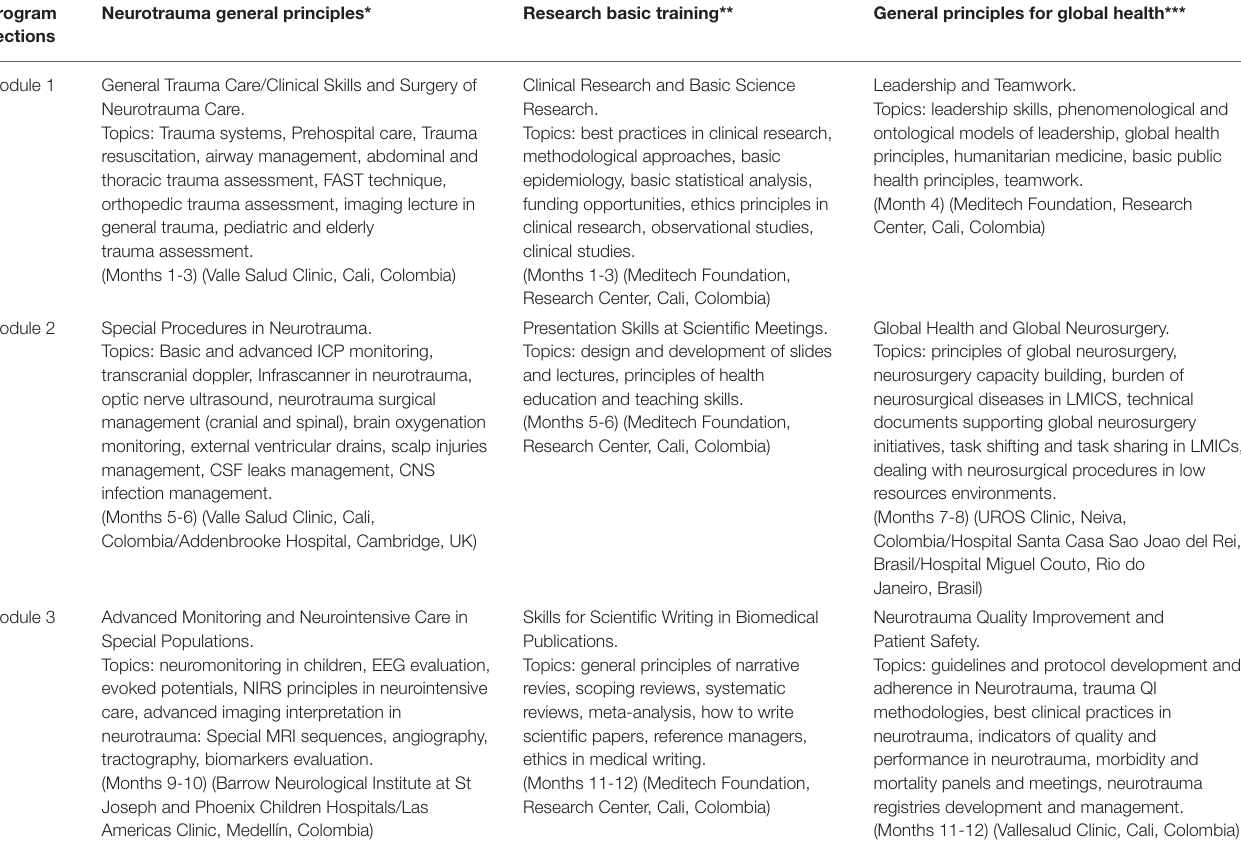
TABLE 1 | Global Neurotrauma International Fellowship Program academic sections, rotation sites, and modules. Program